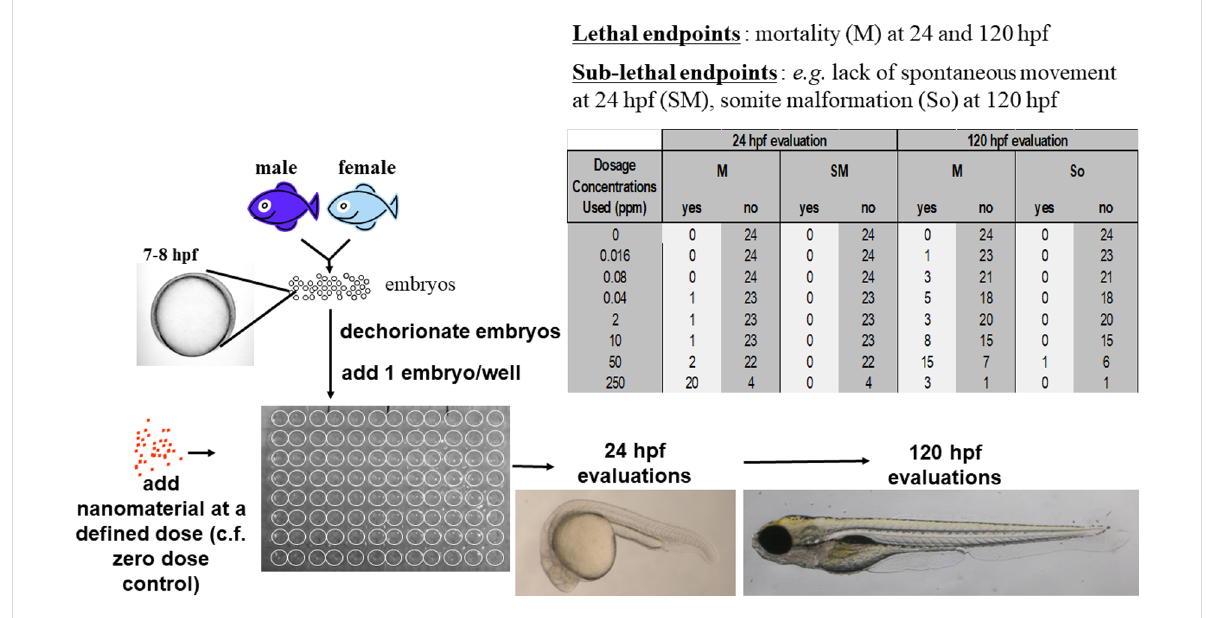
Figure 1: The laboratory method used to obtain the raw counts data for the lethal and sub-lethal endpoints evaluated for each tested engineered nanomaterial (ENM) for which data are reported in the Nanomaterial Biological-Interactions (NBI) Knowledgebase. At the start of the experiment, at around 7–8 hpf, a fixed number of embryos are exposed to a fixed dose of ENM. At 24 hpf, for each tested dose, including the zero-dose control, the endpoint is observed (“yes”) or not observed (“no”) for a certain number of those embryos. At 120 hpf, observations are made for the embryos that